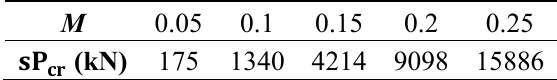
). (cid:2913)(cid:2928)